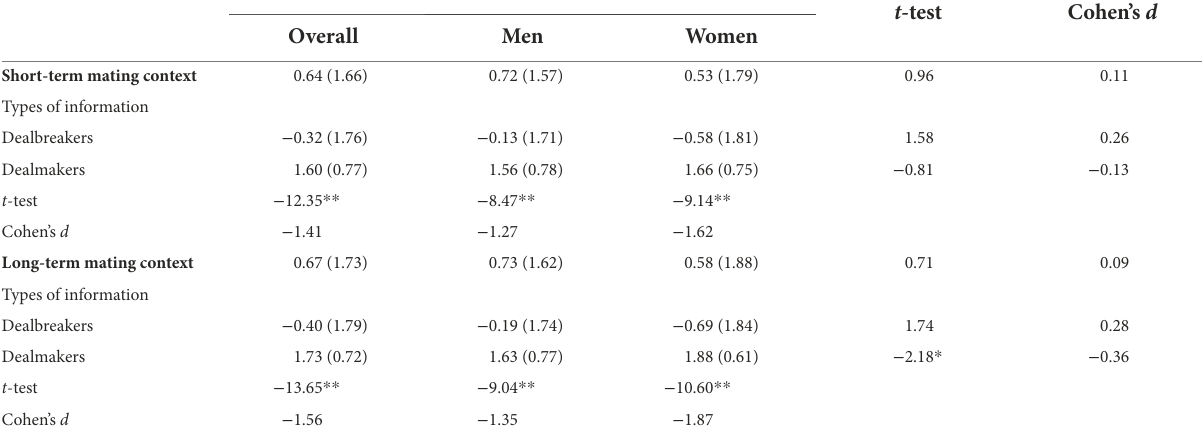
TABLE 1 Between- and within-subjects effects of participants’ sex and the presentation of dealbreakers or dealmakers on change in interest in short-term and long-term mating contexts (Study 1).